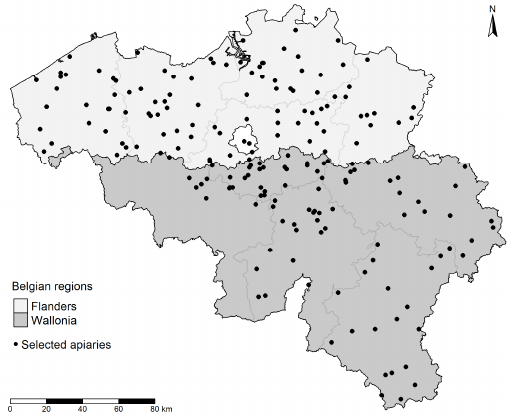
Figure 1. Map of Belgium and its provinces showing the locations of the selected apiaries (black dots). Provinces in Flanders in light grey, provinces of Wallonia in dark grey.